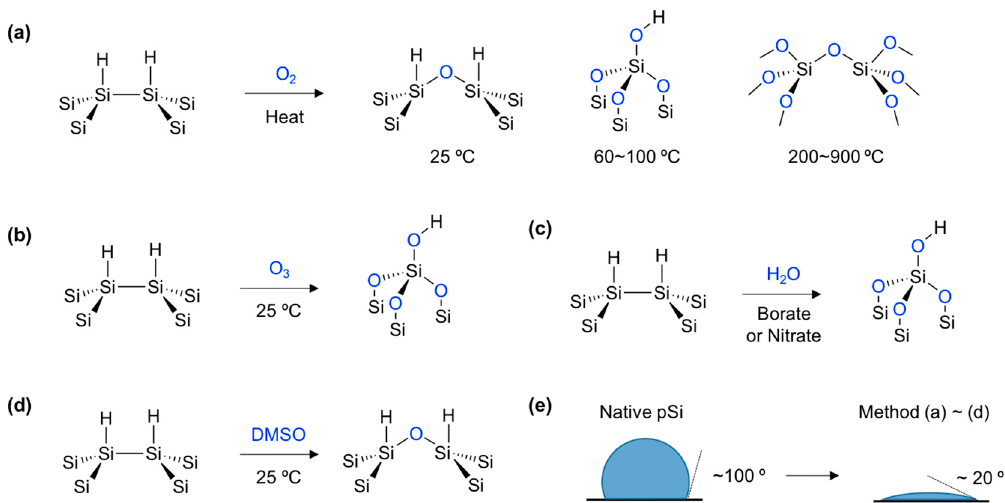
Figure 3. Surface oxidation of native porous silicon (pSi, Si–H). ( a ) Oxidation with a gas-phase oxidant, O 2 , in different temperatures. ( b ) Ozone (O 3 ) oxidation. ( c ) Oxidation in aqueous media (H 2 O) with an oxidant (borate or nitrate). ( d ) Oxidation by organic oxidant (DMSO). ( e ) Water contact angle of native pSi and its surface oxidized product.